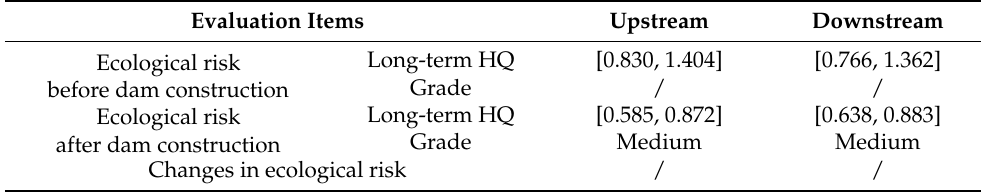
Table 2. Long-term HQ evaluation result of Cu based on traditional HQ